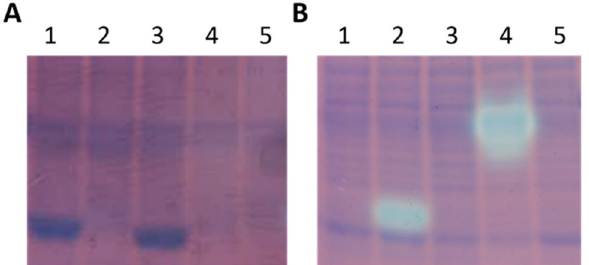
Figure 3. The zebrafish ( Danio rerio ) tenA-like thiaminase I gene encodes a functional thiaminase. Solubility and thiaminase I activity of recombinant candidate thiaminase I genes overexpressed in Escherichia coli , stained for activity showing thiamine degradation as clear areas, and with subsequent Coomassie blue protein stain. Gels are cropped to show relevant lanes and mobility range; original gels are presented in Supplementary Fig. 9. Panel A, insoluble fractions; Panel B, soluble fractions; lane 1, common carp ( Cyprinus carpio) , lane 2, zebrafish; lane 3, alewife ( Alosa pseudoharengus ); lane 4, Paenibacillus thiaminolyticus ; lane 5, empty pET52b vector.